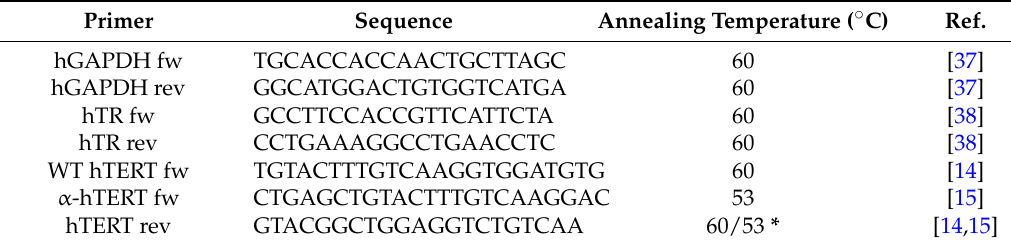
Table 2. Primers used in qPCR. * Two annealing temperatures are provided for the hTERT reverse primer since the temperature was dependent on the respective forward primer used (WT or α hTERT). Primer Sequence Annealing Temperature ( ˝